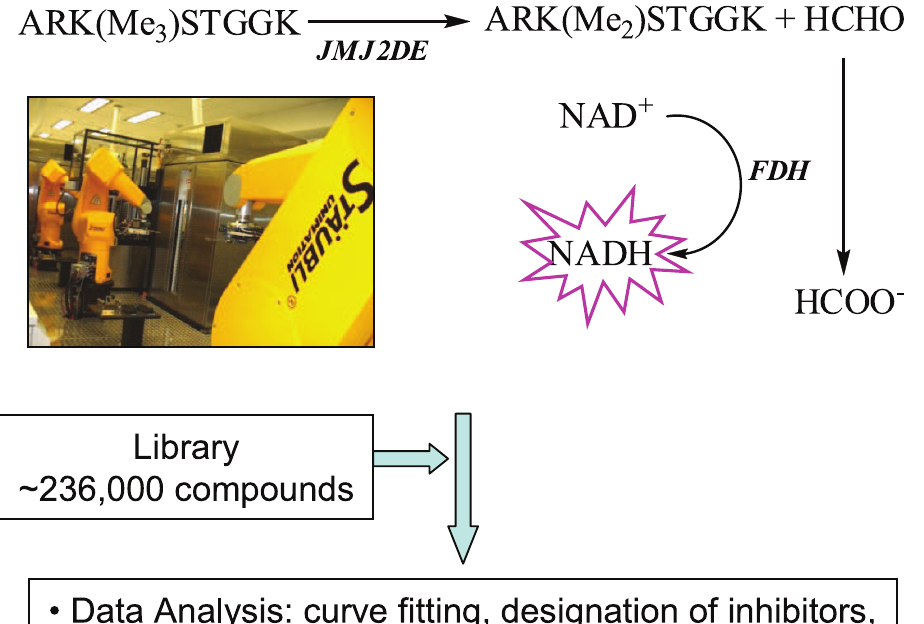
Figure 1. Screening and Hit Prioritization Strategy.